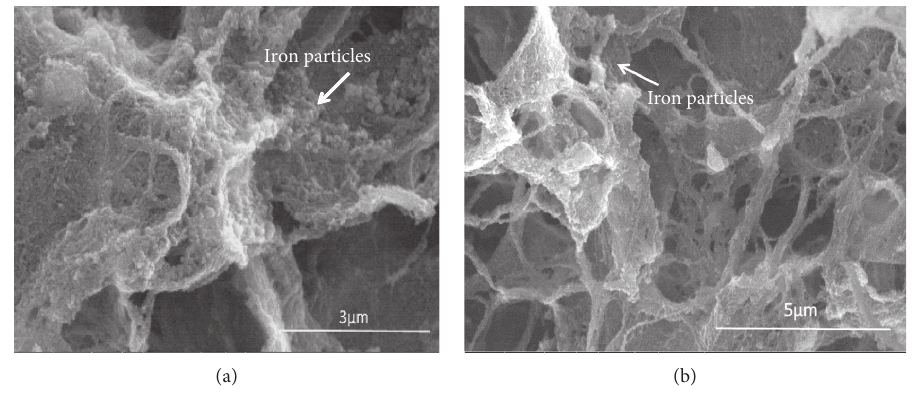
Figure 3: Iron nanoparticles in MMFC